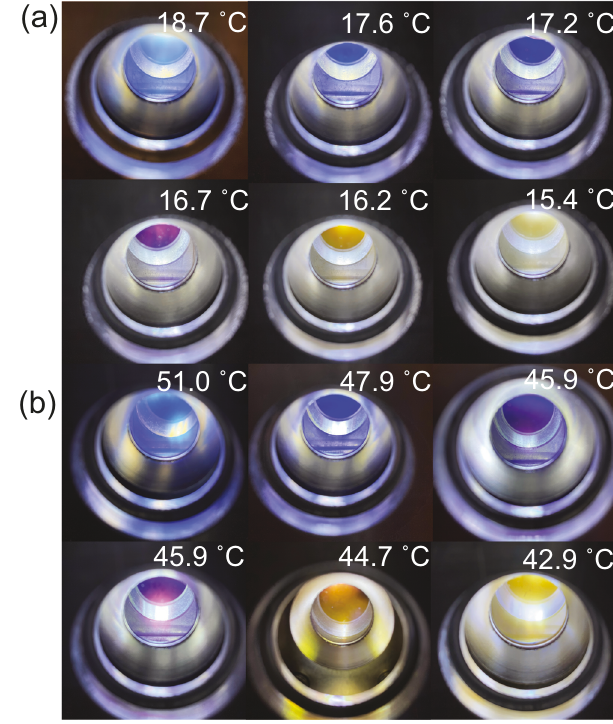
Fig. 4 The customizable color transition temperature realized by different binary solvents. SeedGel prepared with binary solvents of a water/2,4-lutidine and b water/3-methylpyridine shifts the color transition point to lower and higher temperatures, respectively, when compared to that of SeedGel prepared with